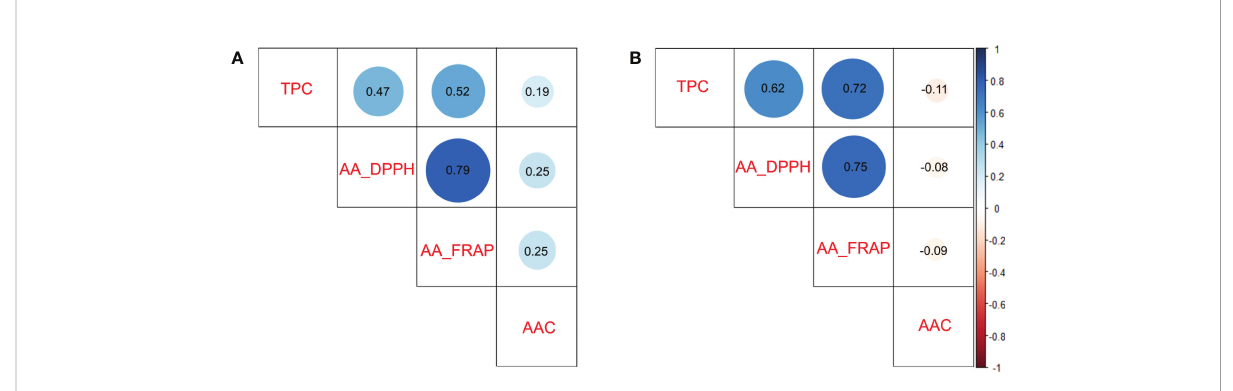
AA, and tetraploids tend to have higher values of TPC (Figure 3A). The phenotypic traits grouped the diploid and tetraploid samples in three clusters (Supplementary Table S3). In diploids, the genotypes with pink-red potatoes (n=13) with the highest values for TPC (mean=1352.92 ± 486.03 mg